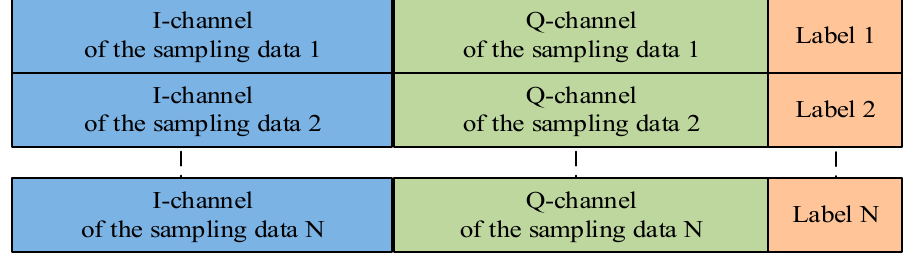
Figure 5. Database framework.